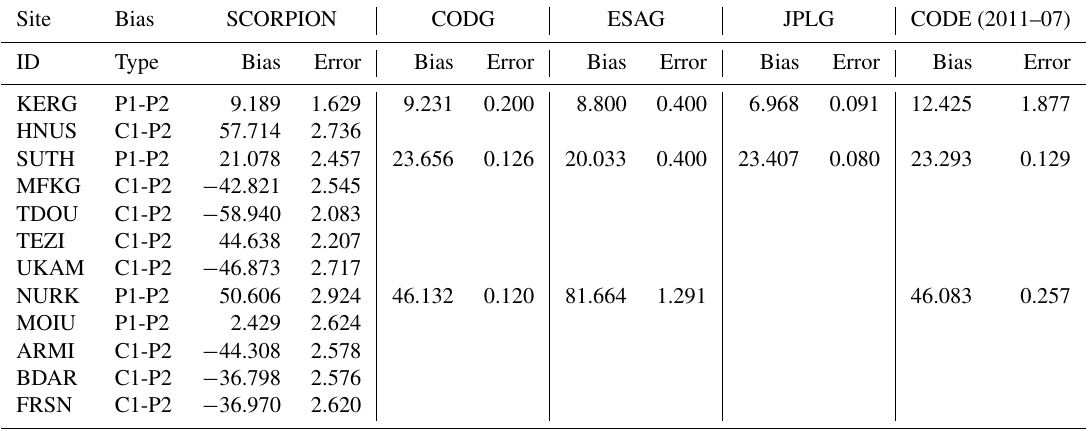
Table 2. Receiver biases and error estimates, in TEC units, from SCORPION, IONEX maps, and the July 2011 CODE monthly report, indicating whether the coarse acquisition (C1) or precise code (P1) signal is used for the L1 frequency. Site Bias